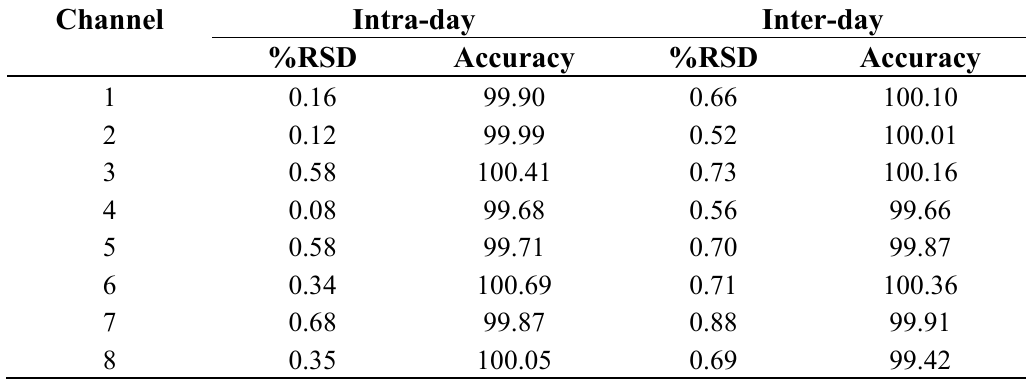
Table 1. Precision and accuracy of each channel of the analgesic meter.